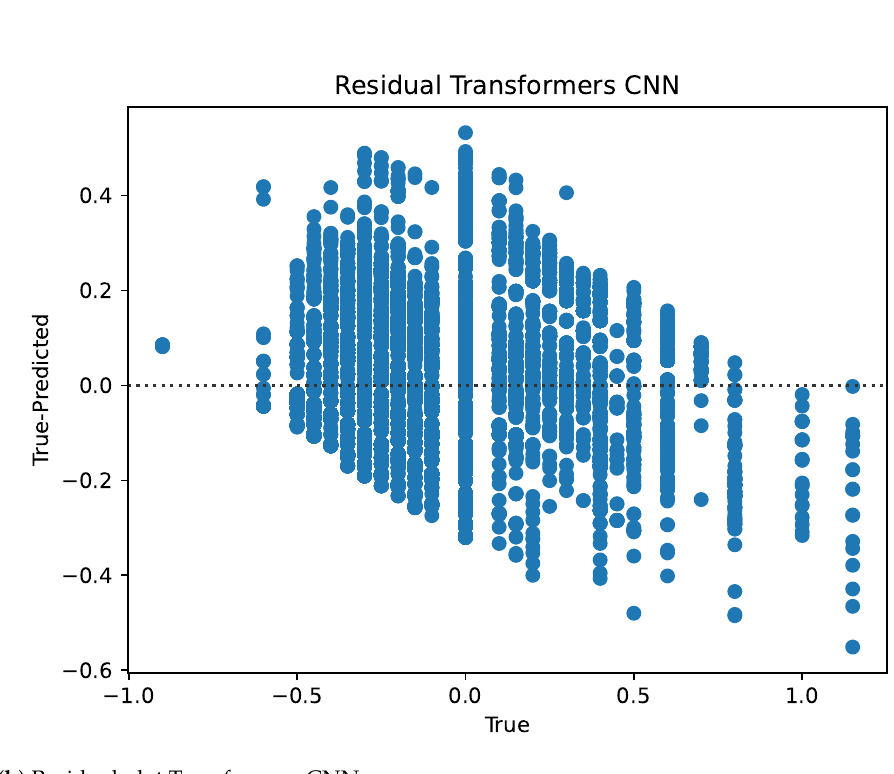
Figure 14. Transformers CNN results for ST deviation calculation in ECG time